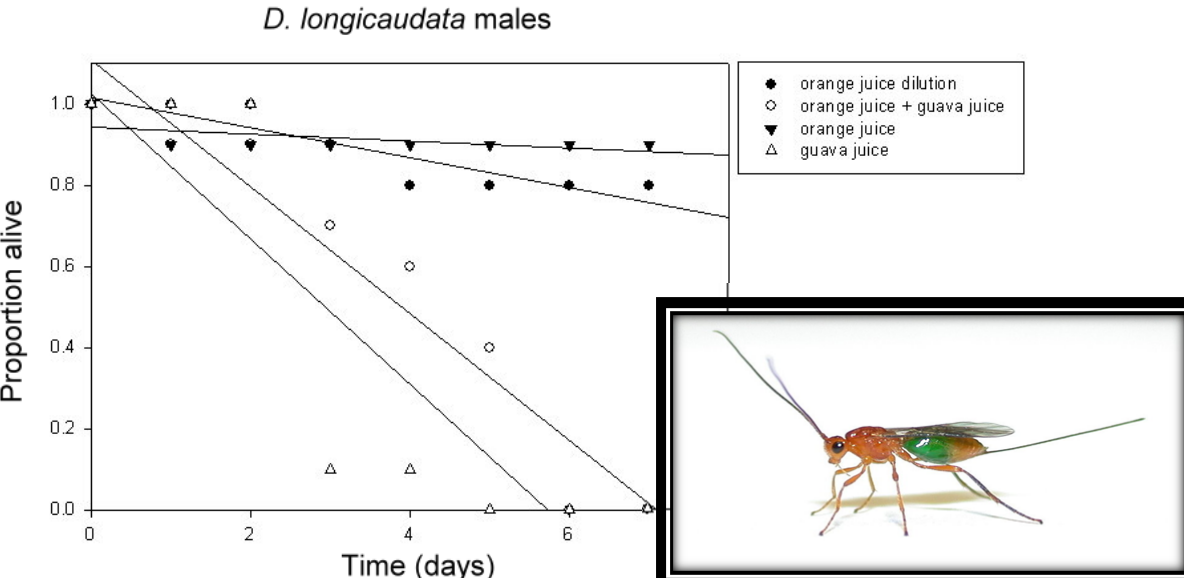
Figure 4. Obtaining adult food from the same substrate occupied by hosts saves the energy and avoids the risks inherent in separate foraging. Although opiine braconids flourish on various fruit/ fruit juices, such as orange ( Citrus sinensis L.) and peach ( Prunus persica [L.] Batsch), others appear to be toxic. For example, parasitoids fed on guava (inset of D. longicaudata that had consumed marked juice) die quickly, even when guava is diluted with nutritious orange juice. As a consequence not all environments may offer the same opportunities to safely obtain cheaply-acquired carbohydrates. Thus different habitats may require different food-foraging tactics. Volatile cues are used by tephritid-attacking braconids to locate fruit juices and as might be predicted, those from a high quality food such as orange are generally more attractive than those of low quality guava.